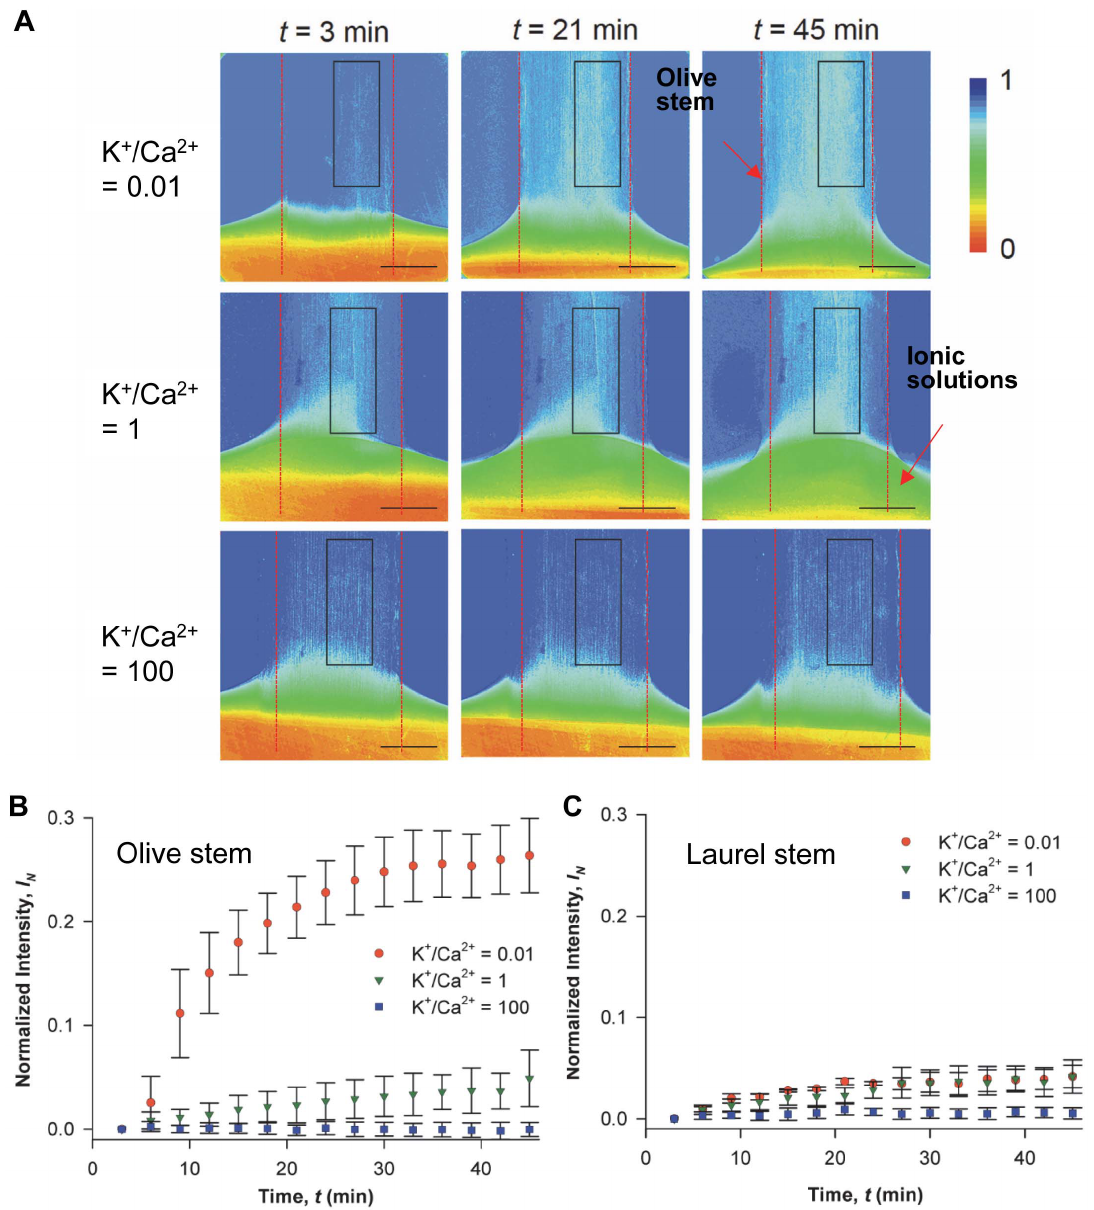
Figure 1. Synchrotron X-ray micro-imaging of the ascent of water containing K + and Ca 2 + in xylem vessels. A ) Typical X-ray images showing temporal changes in the spatial distribution of ionic solution uptake mediated by varying K + /Ca 2 + ratios from 0.01, 1, to 100 in the excised olive stems. Synchrotron X-ray imaging was employed to observe ionic water uptake directly through the xylem conduits of olive stems with high temporal and spatial resolution. Excised stems with a height of 15 cm took up ionic solutions with different K + /Ca 2 + ratios under the same total ion concentration. Intensity-based colored figures in each column show qualitative information regarding water ascent at different ionic ratios: K + /Ca 2 + = 0.01 (1 st ), 1 (2 nd ), and 100 (3 rd ), respectively. Light blue color represents the ascent of multi-ionic solutions mixed with iopamidol as a contrast agent. The X-ray image of each column was captured at 3, 21, and 45 min, respectively. Scale bar represents 500 m m. Temporal variations in the normalized X-ray absorption intensities in the region of interest for B ) olive stems and C ) laurel stems. Orange circles denote K + /Ca 2 + =0.01; green rotated triangles denote K + /Ca 2 + =1; purple rectangles denote K + /Ca 2 + =100. The normalized intensity values directly represent ionic solution uptake. These figures were derived from three repeated experiments (n=3) and error bars indicate standard deviations. This procedure was performed to enhance the sensitivity of detection of light intensity variations during the experiment and to quantitatively compare the uptake behaviors of ionic solutions. ) were color-coded The enhanced X-ray and neutron images ( ~ II 0 n into 32 levels and processed with the jet colormap provided by Matlab, respectively.